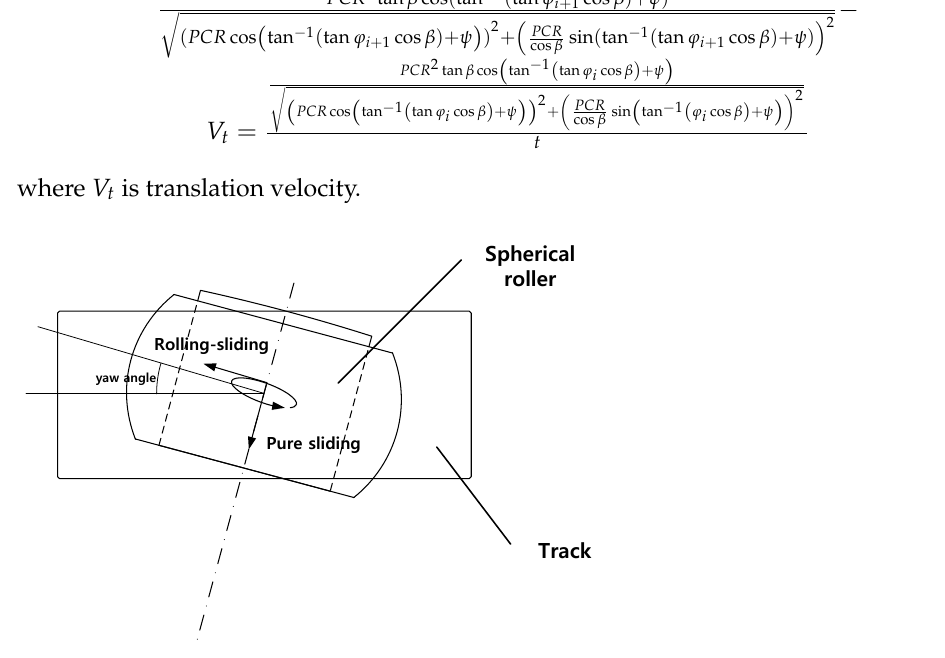
Figure 4. Pure sliding and rolling-sliding motion between spherical roller and track. Actual sliding velocity is the product of translation velocity and rolling—sliding